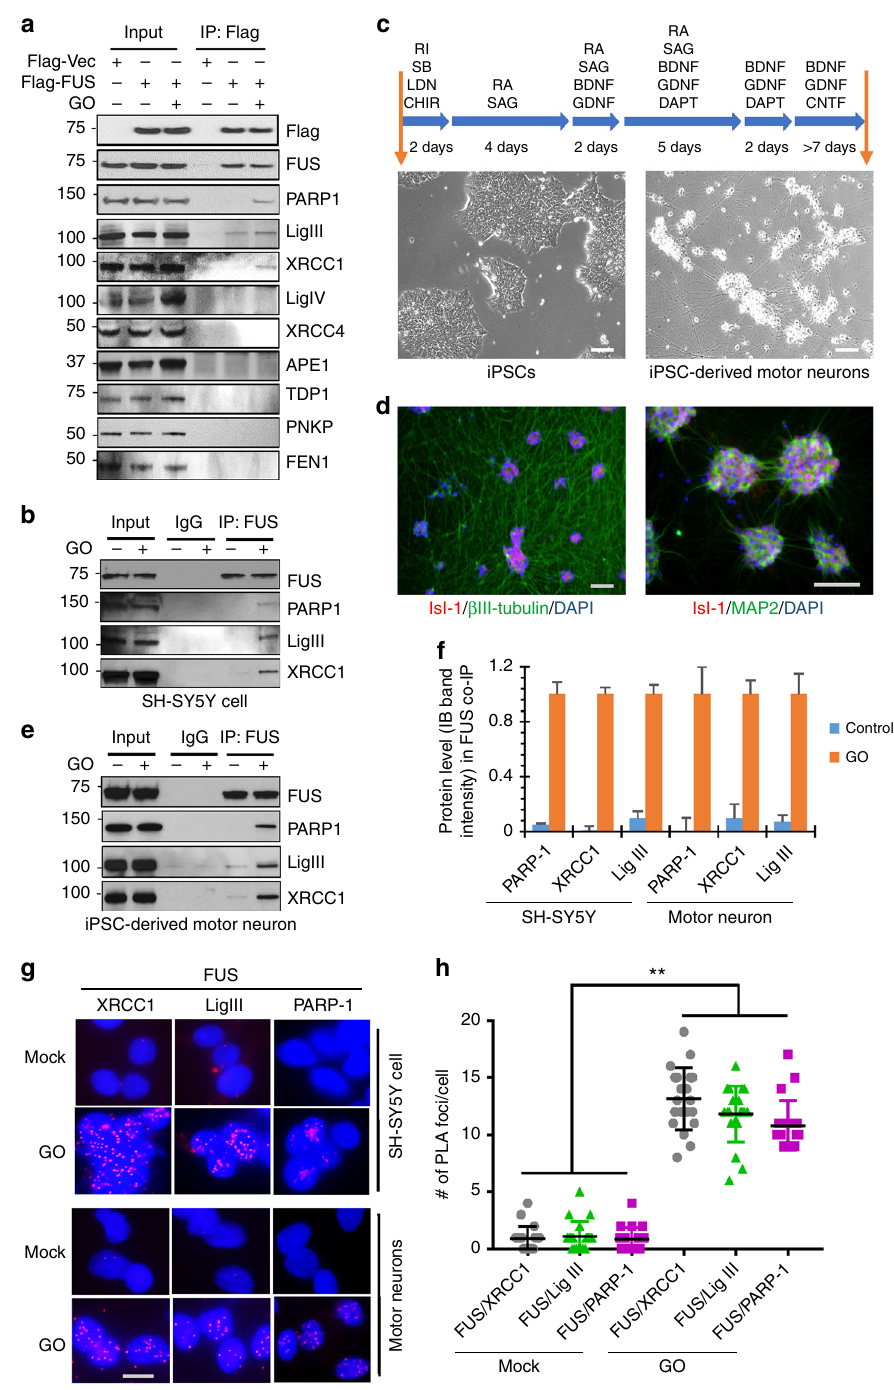
Fig. 2 FUS forms a complex with PARP1, XRCC1, and LigIII. a IB of Flag-FUS co-Immunoprecipitation (co-IP) from HEK293 cells for oxidative DNA damage repair proteins with or without GO treatment (100 ng/ml for 1 h). The IP was performed with anti-Flag antibody. b IB of endogenous FUS co-IP from SH- SY5Y cells for PARP1, XRCC1, and LigIII. The IP was performed with anti-FUS antibody. c Scheme of human iPSC line differentiation to motor neurons. Representative phase-contrast images of iPSC and differentiated motor neurons are shown. Scale bar = 50 µ m. d Immuno fl uorescence (IF) staining of motor neuron markers. Representative images of motor neurons that stained Isl-1, MAP2, or β III-tubulin indicated ~80% differentiation ef fi ciency. Scale bar = 50 µ m. e IB of endogenous FUS co-IP from differentiated motor neurons for PARP1, XRCC1, and LigIII. f Quantitation of IB band intensity in Fig. 2b, e to show level change of PARP-1, XRCC1, and LigIII in FUS IP after GO treatment. The error bars are standard deviation of experiments performed in triplicate. g PLA of FUS vs PARP1, XRCC1, or LigIII in SH-SY5Y and iPSC-derived motor neurons with or without GO treatment. Nuclei stained with DAPI. Scale bar = 5 µ m. h Quantitation of PLA foci from 25 motor neuronal cells (** p < 0.01, two-tailed unpaired Student ’ s t -test). The error bars are standard